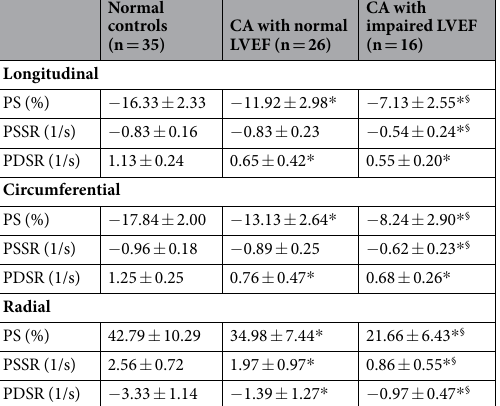
Table 3. Values for left ventricular deformation parameters obtained using feature tracking for global values of all study groups. Notes: The values are the mean ± SD, other abbreviations are the same as in Tables 1 and